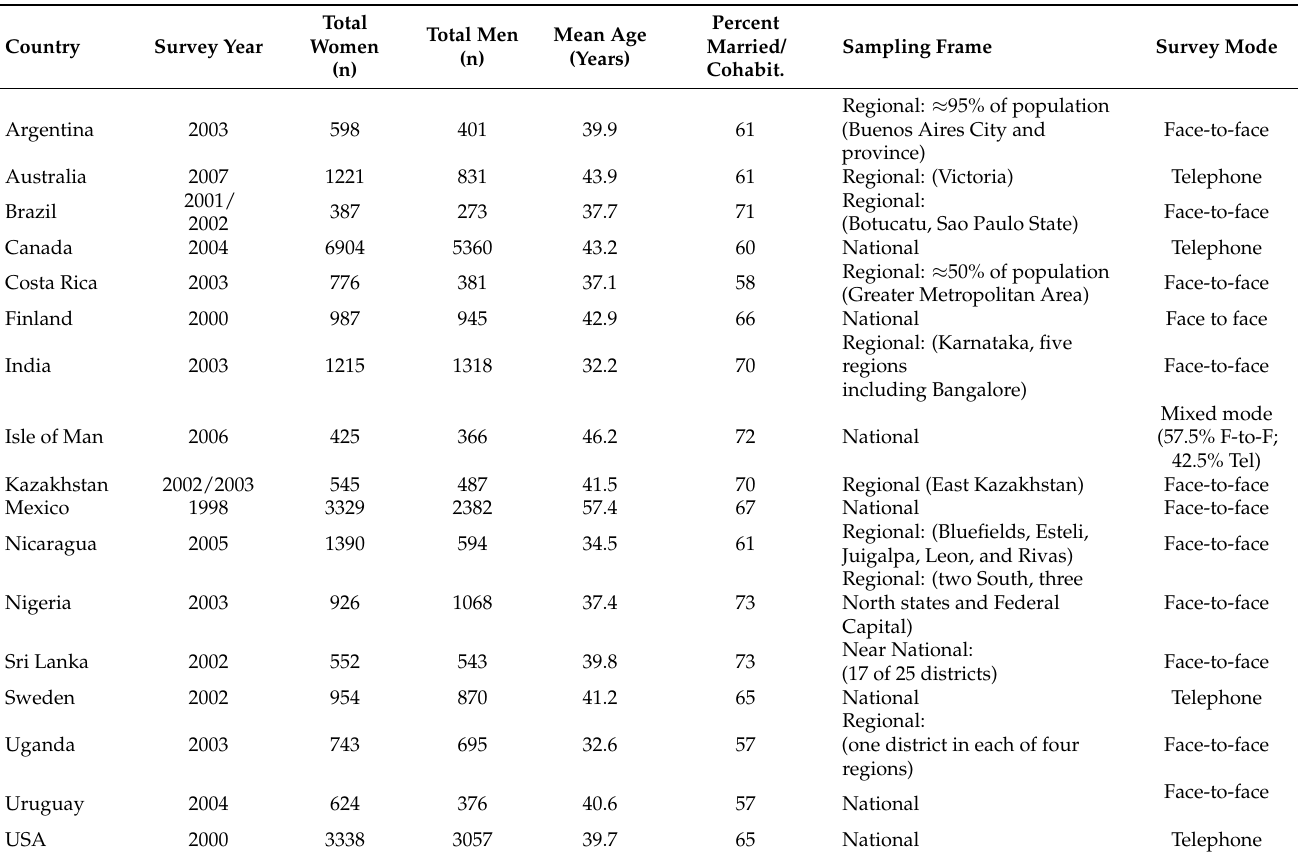
Table 1. Survey Sample